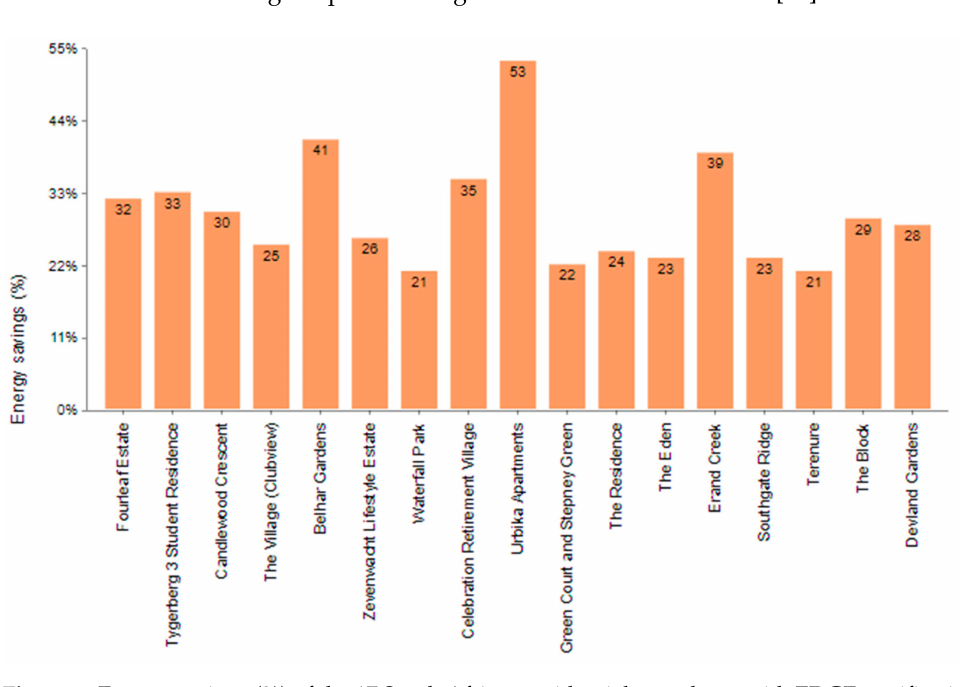
Figure 1. Energy savings (%) of the 17 South African residential complexes with EDGE certification.